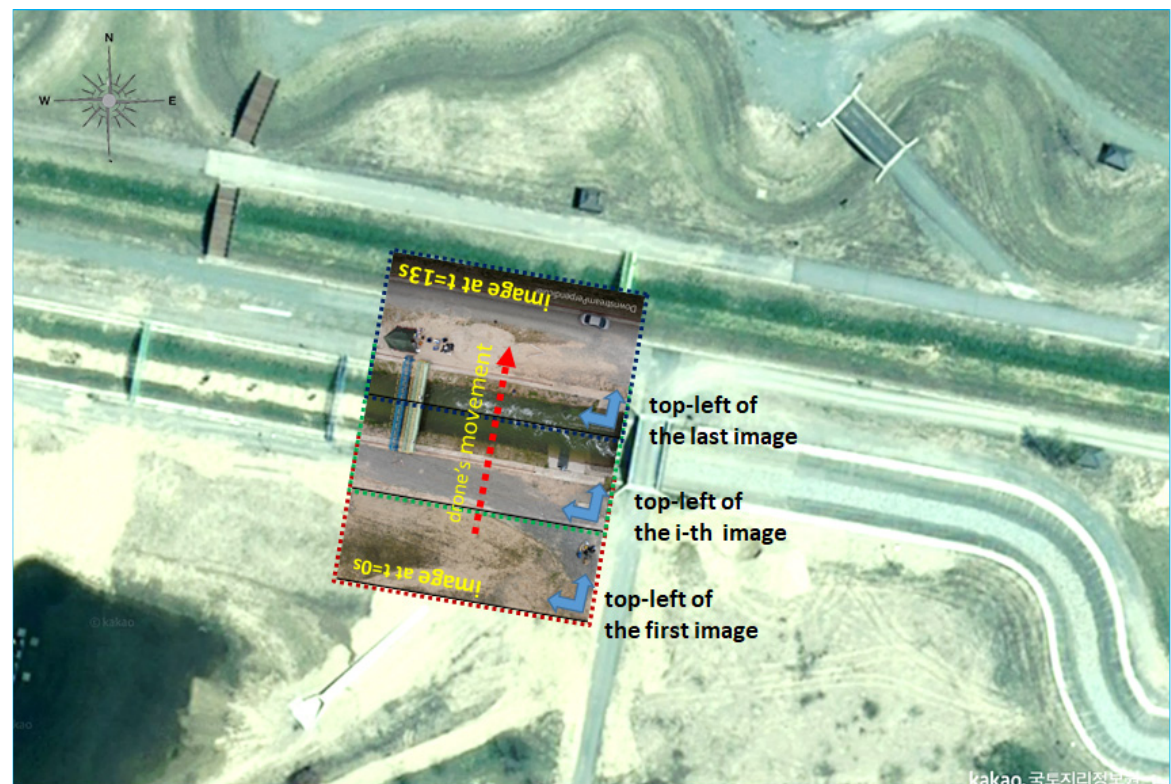
Figure 4. Test site (River Experiment Center) and the drone’s flight path.